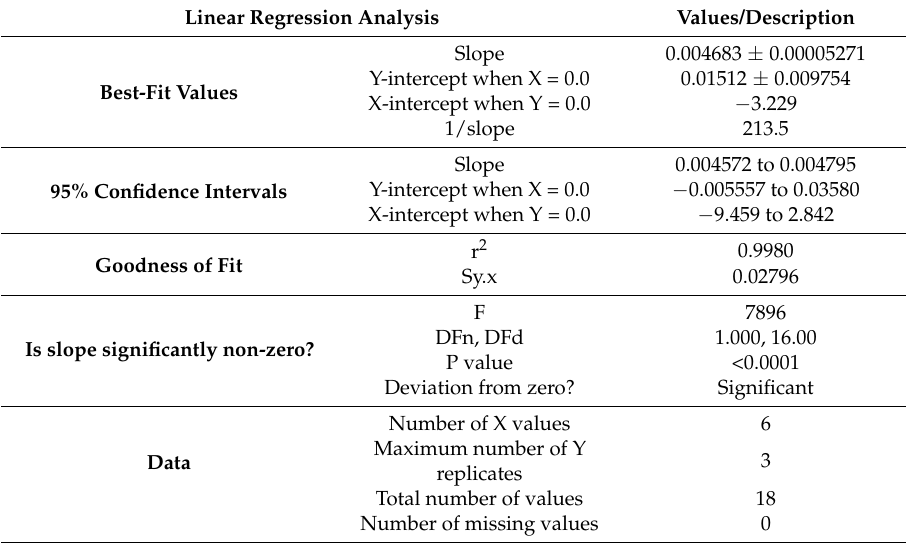
Table 4. Linear regression of the FRAP standard curve obtained using 0–350 µ g/mL of ascorbic acid. Linear Regression